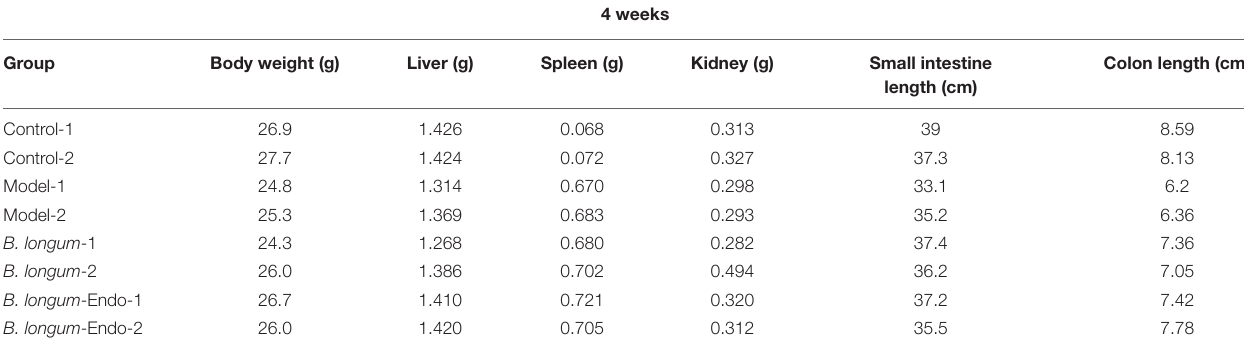
TABLE 2 | Organ parameter changes in mice at 8 weeks after AOM injection.